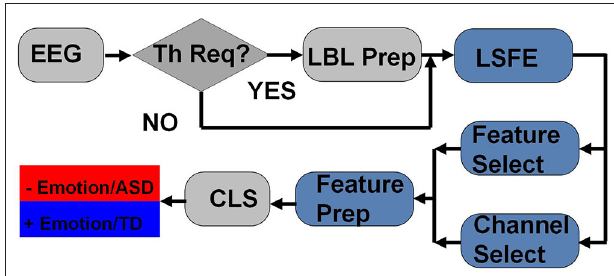
FIGURE 4 | LSFE and classification